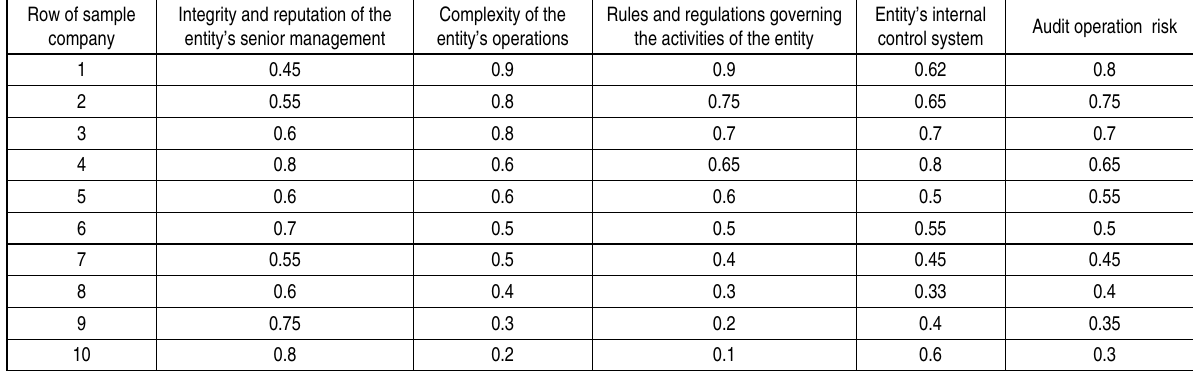
Table 7. Risk of audit operations in 10 sample companies